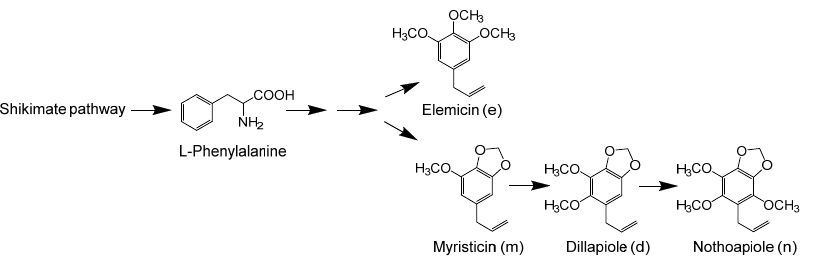
Figure 1. Putative biosynthetic pathway of phenylpropene (PP)-type oils in perilla. In the text, the oil types of each strain of perilla are represented as PP-em, PP-m, PP-md, PP-emd, and PP-mdn, elemicin + myristicin + dillapiole, and myristicin + dillapiole + nothoapiole, respectively.